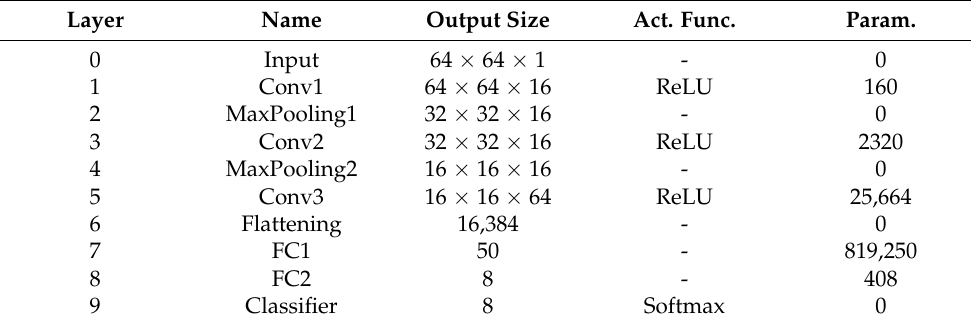
Table 1. Structure of the CNN. Layer